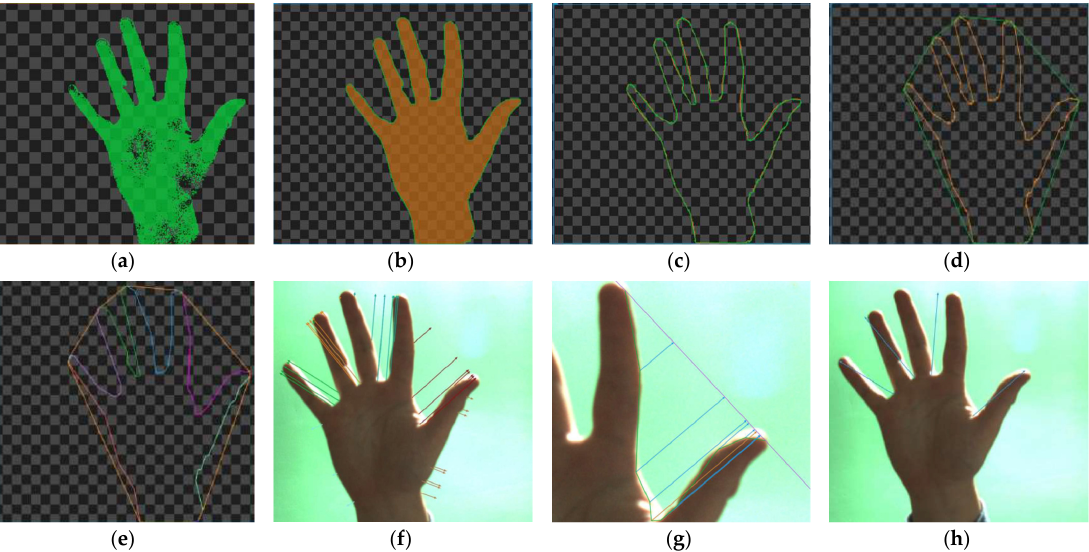
Figure 6. Image of extracted hand area ( a ), hand after morphological closing ( b ), contour of the hand ( c ), convex polygon ( d ), segmented contour ( e ), candidates ( f ), longest candidate searching ( g ), final fingers selection—blue lines ( h ).